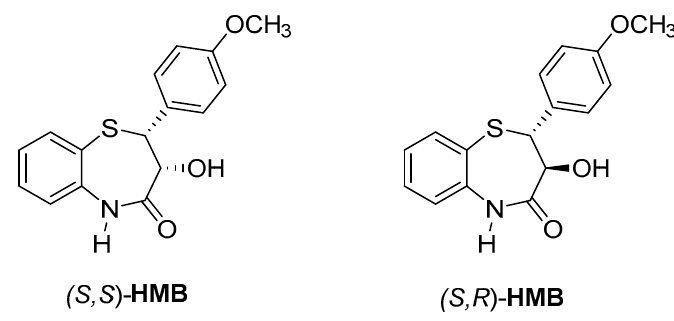
Figure 7. Imitative benzothiazepine derivates.